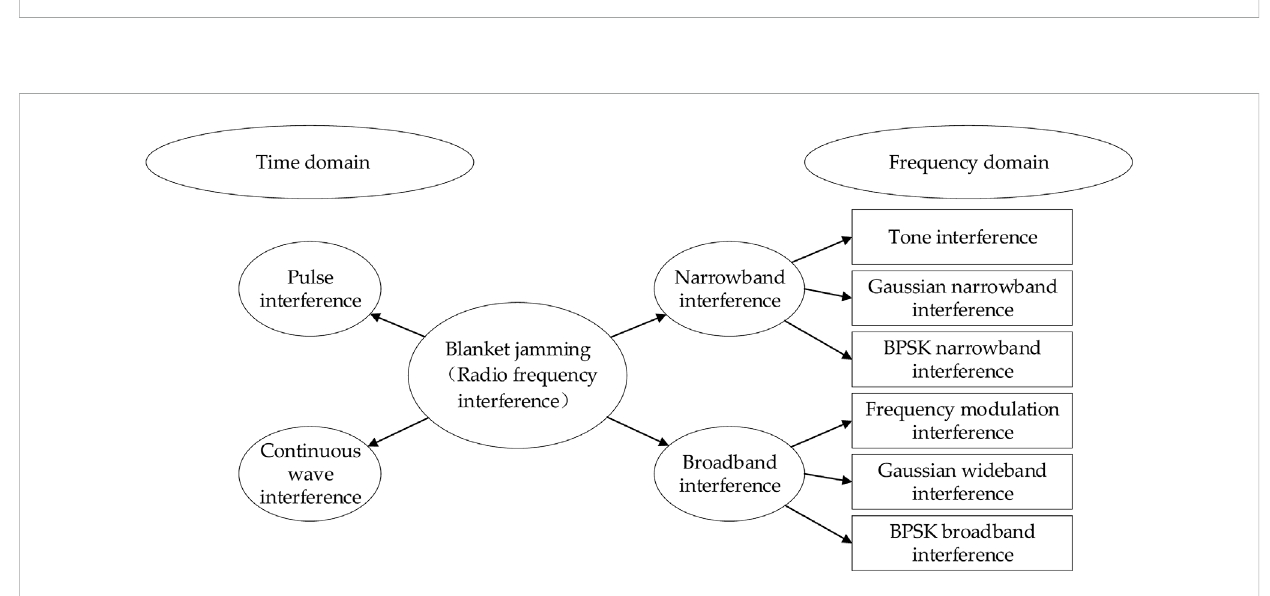
FIGURE 3 Classi fi cation of blanket interference